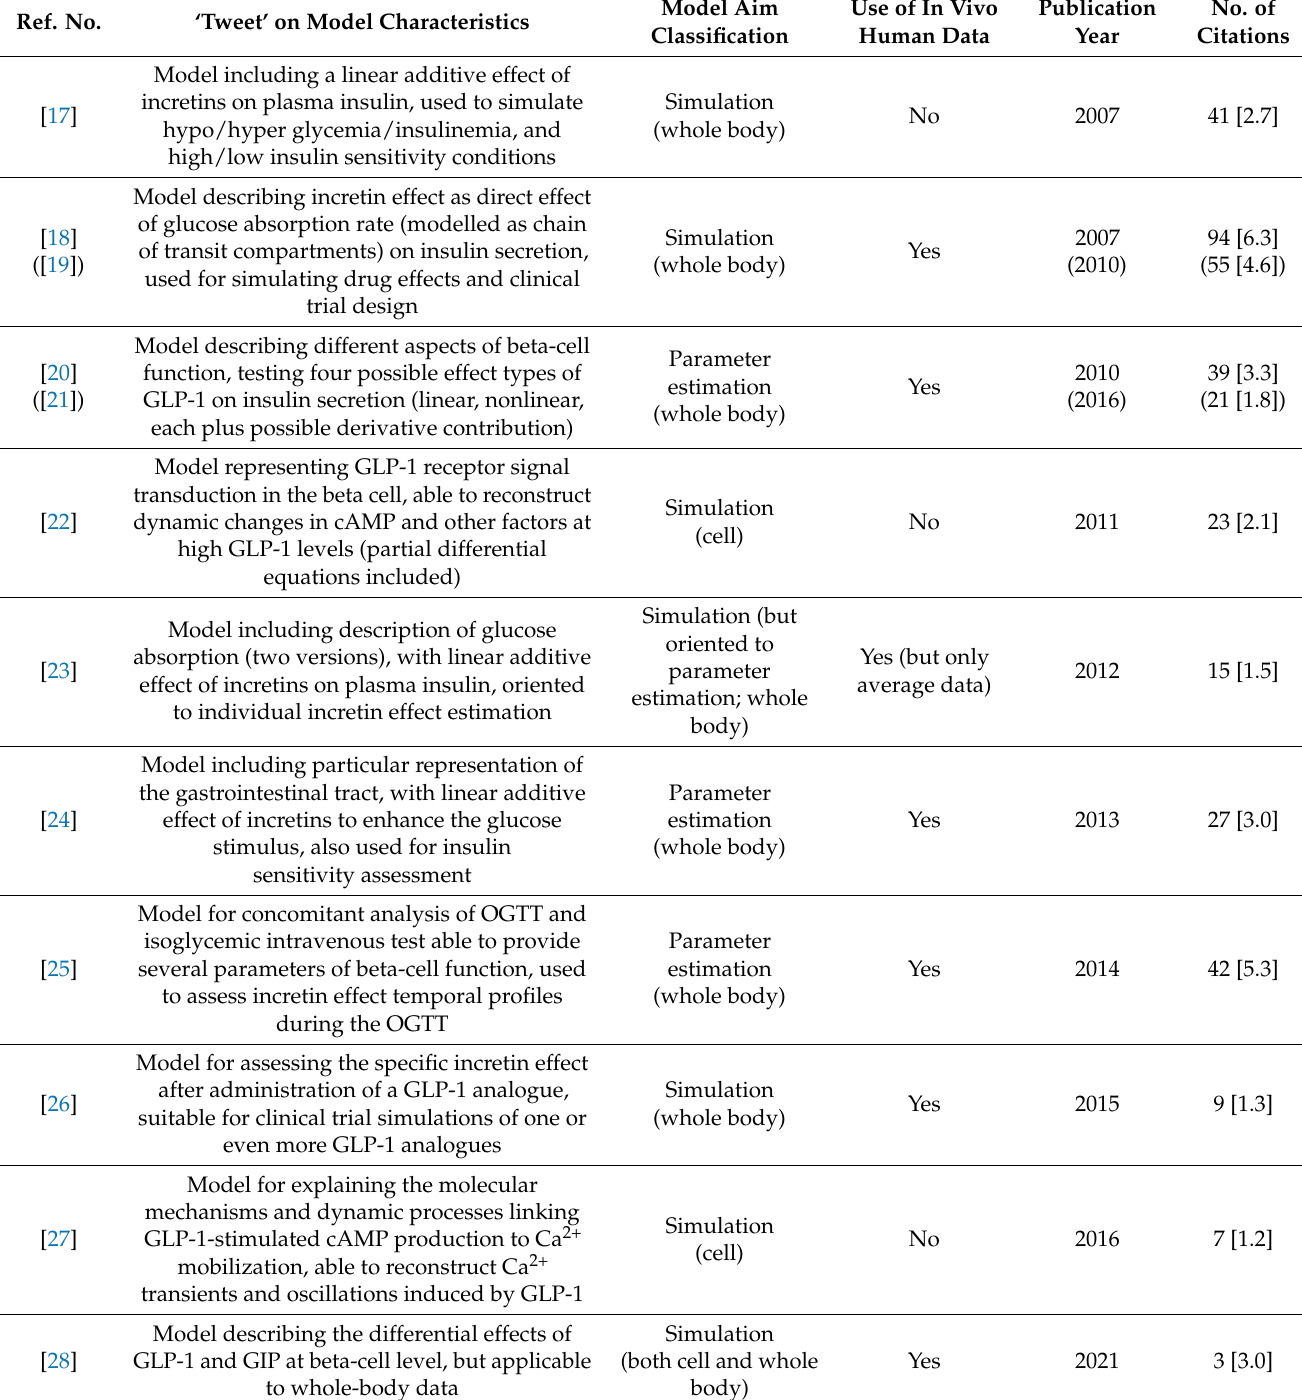
Table 1. Basic information on the models of incretin hormone effects on insulin secretion and beta-cell function. In the “‘Tweet’ on model characteristic” field, a short description ( ≤ 200 characters) on the main model characteristics is reported. In the “Model aim classification” field, either “simulation” or “parameter estimation” is reported (on the individual subject’s data), based on what appears as the main application of the model; model application at cellular/organ level or whole body is also specified. To provide an indication of each study impact, the number of citations is reported in the “No. of citations” field (both the absolute number and the number per year, in square brackets). Source: Google Scholar (last checked: 31 January